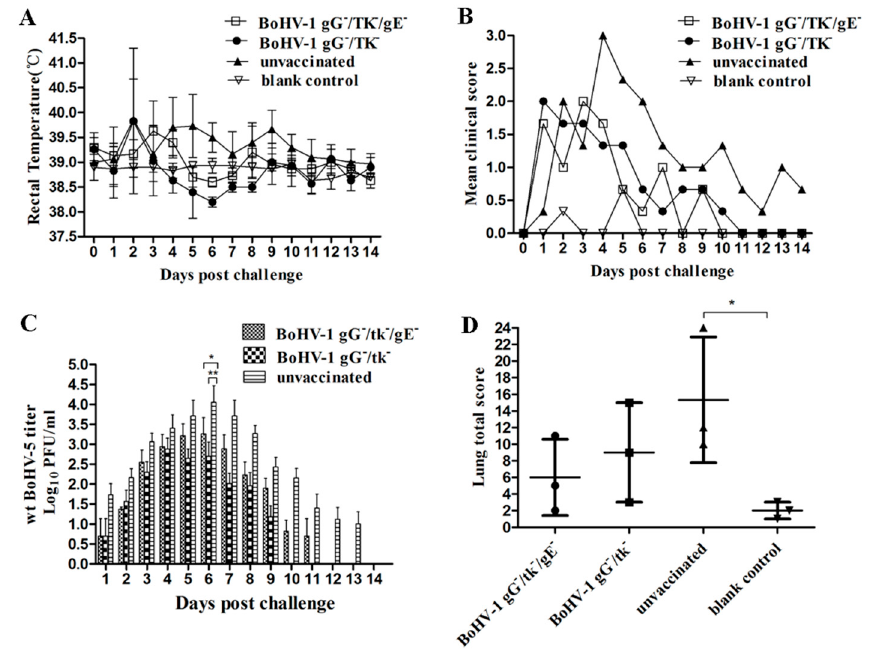
Figure 5. Protective efficacy of BoHV-1 gG-/tk-/gE- against wt BoHV-5 ( A – D ) challenge in calves. ( A ) Temperature change. ( B ) Clinical scores. ( C ) Nasal virus shedding. ( D ) Lesion scores of lungs. The mark (*) with p < 0.05 and (**) with p < 0.01 were considered to indicate a significant difference.